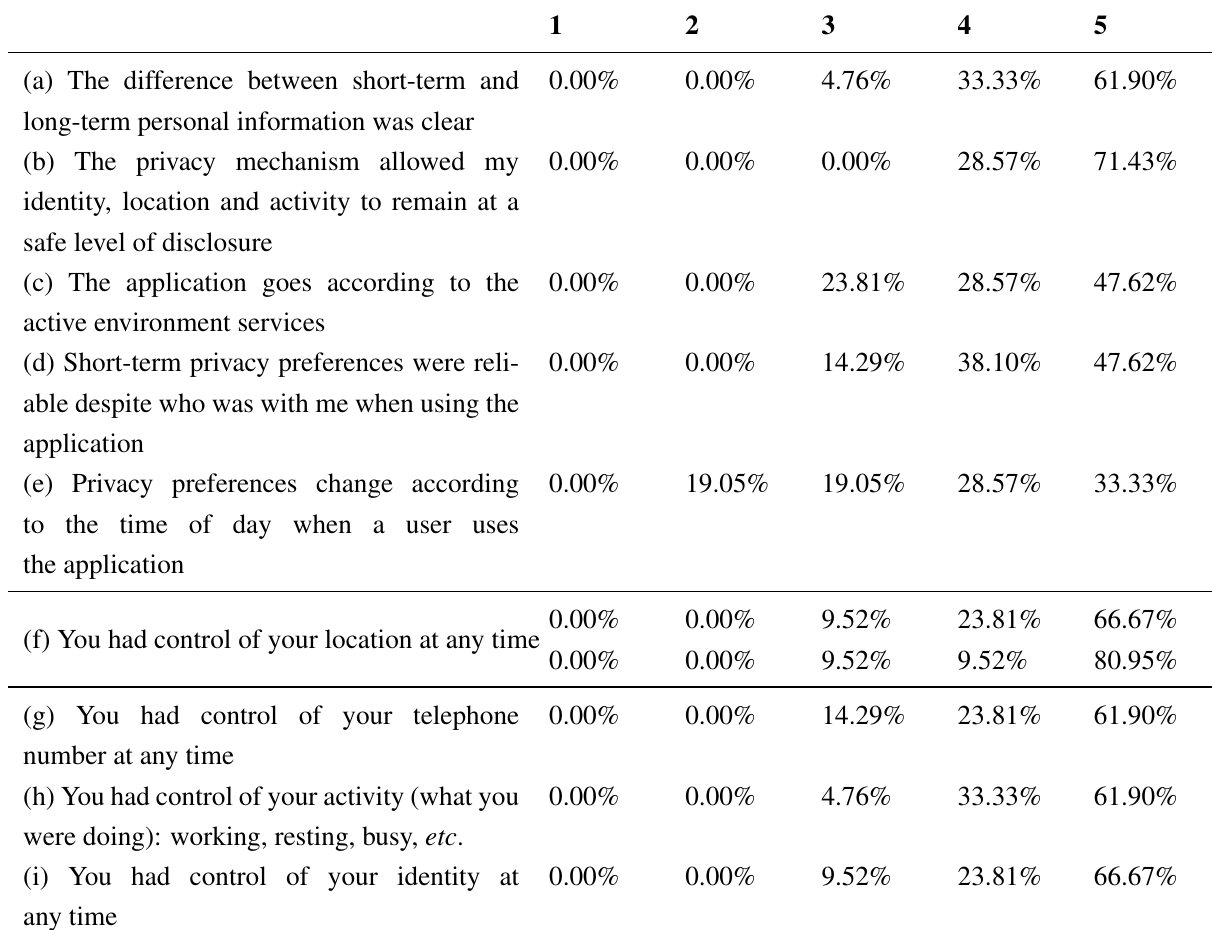
Table 7. Perception of privacy